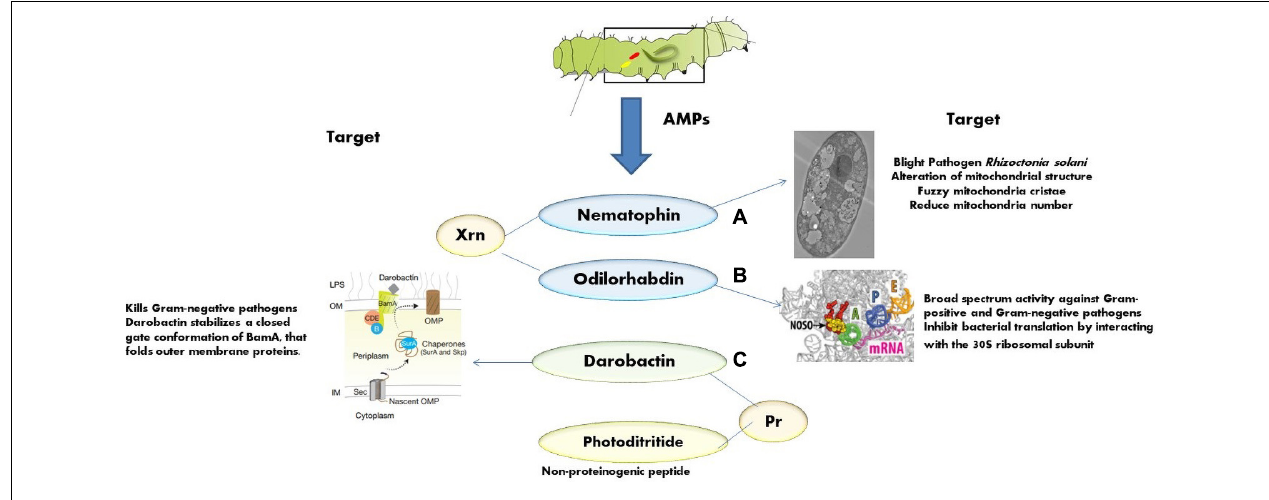
FIGURE 3 | Mode of action of various AMPs: (A) nematophins act on mitochondrial structure of Rhizoctonia solani [adapted from Zhang et al. (2019)]; (B) odilorhabdins act on the ribosome and inhibit protein synthesis in Gram-negative bacteria [adapted from Pantel et al. (2018)]; (C) darobactins act on outer membrane chaperone [adapted from Imai et al.